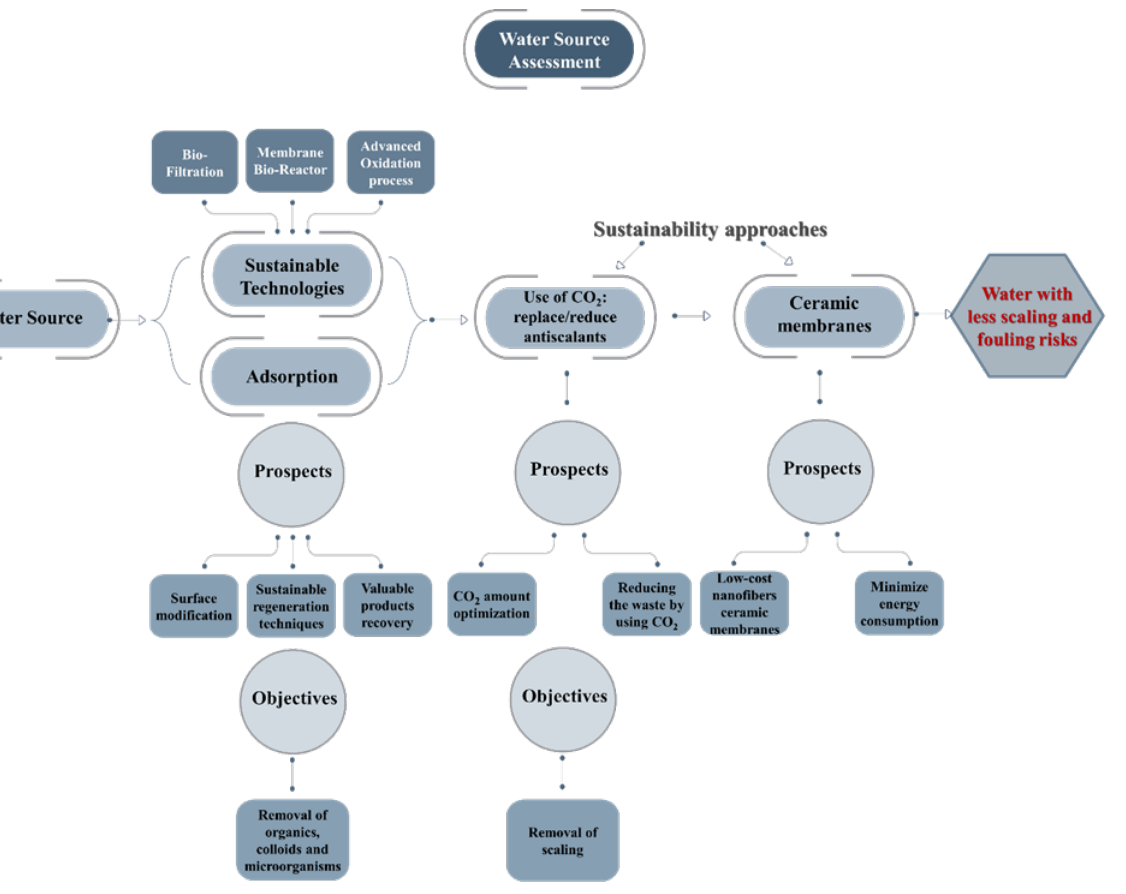
Figure 9. A suggested framework for effective hybrid RO pretreatment with a focus on Gulf coun-